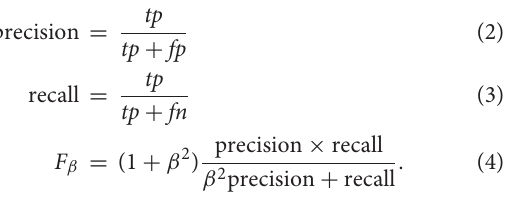
Figure 3C Hough line detection results, Figure 3D polygon